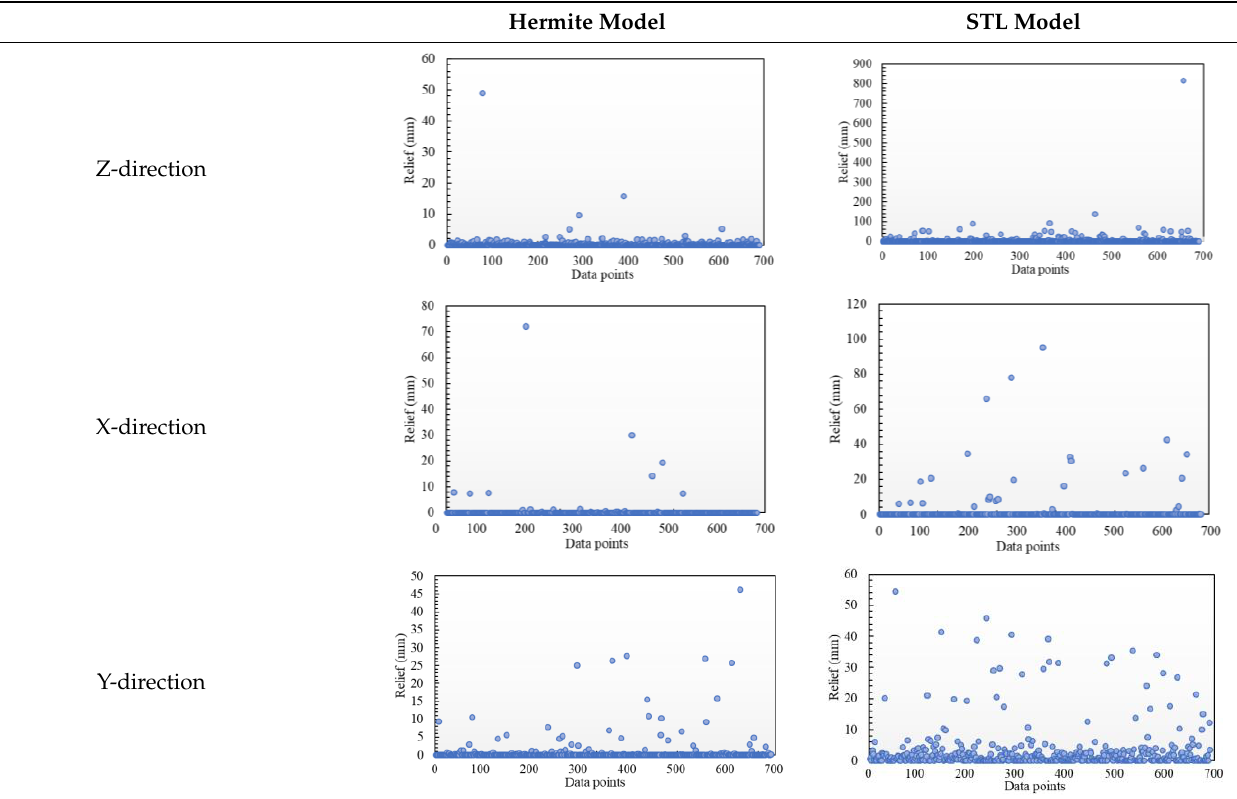
Table 2. Mean deviation in the three directions in group 1.